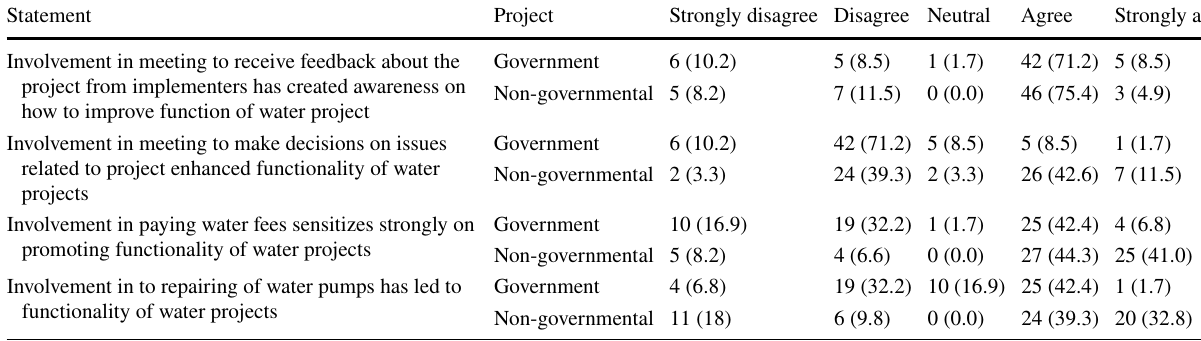
Table 6 Effectiveness of PM&E in ensuring functionality of water